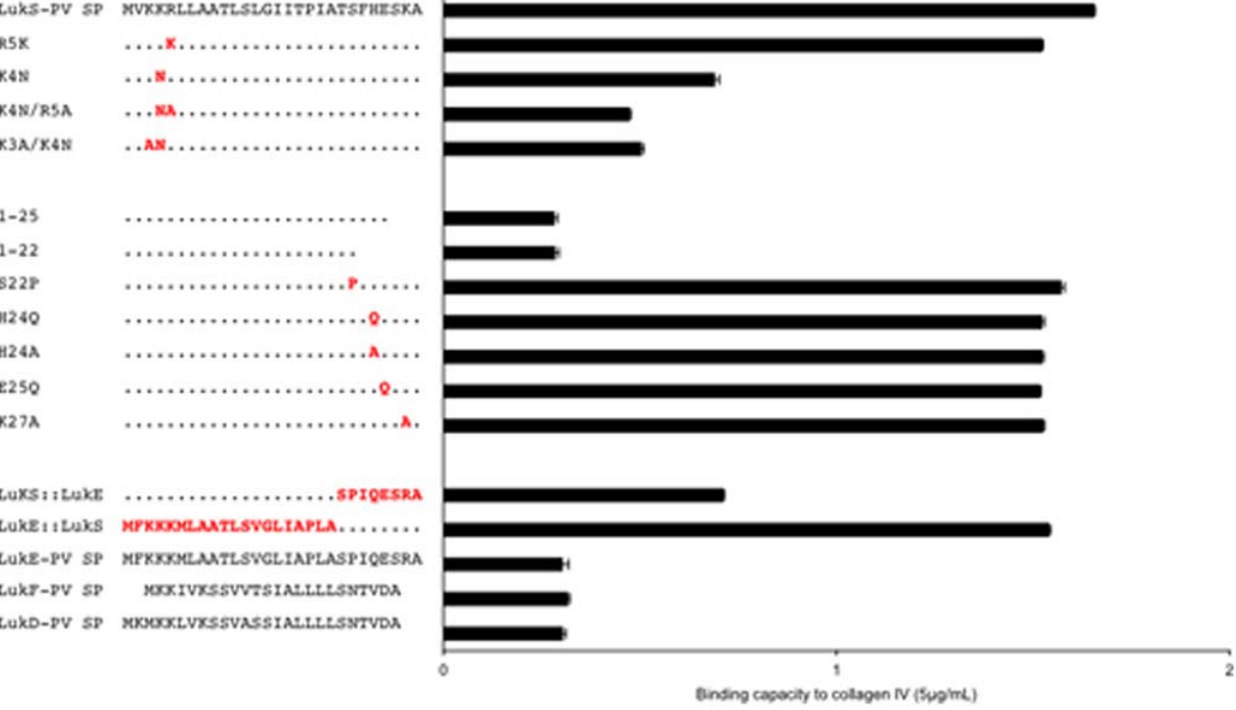
Figure 12. Identification of LukS-PV signal peptide residues involved in the adhesion phenotype using mutagenesis. Sequences of wild type LukS-PV signal peptide (top) and mutants are shown on the left side, together with the alignment of sequences of LukE, LukF-PV and LukD signal peptides (bottom). The binding capacity of the corresponding sequences to type IV collagen (5 m g/mL, Sigma) is shown on the right side. Mutated amino acids are colored red while other LukS-PV SP amino acids are represented by dots. Deletion mutants of LukS-PV SP are denoted by their sequence length (1–25 and 1–22).